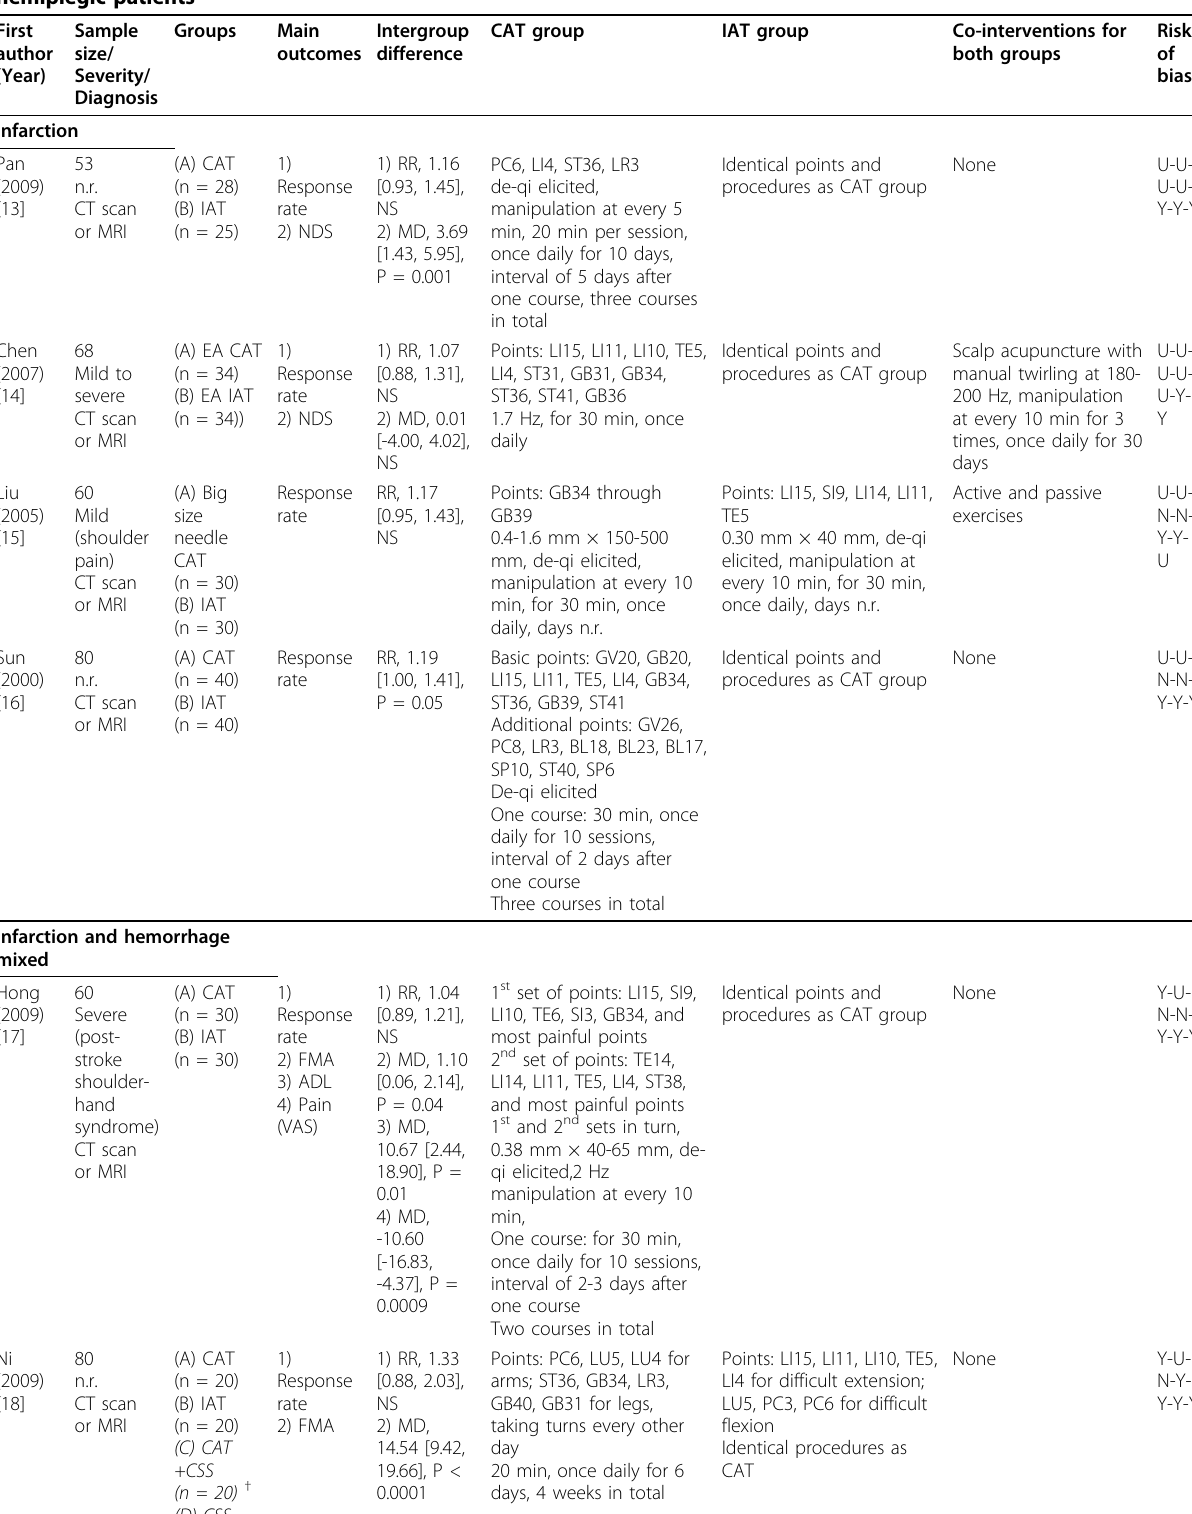
Table 1 Key data from RCTs comparing contralateral acupuncture (CAT) to ipsilateral acupuncture (IAT) in post-stroke hemiplegic